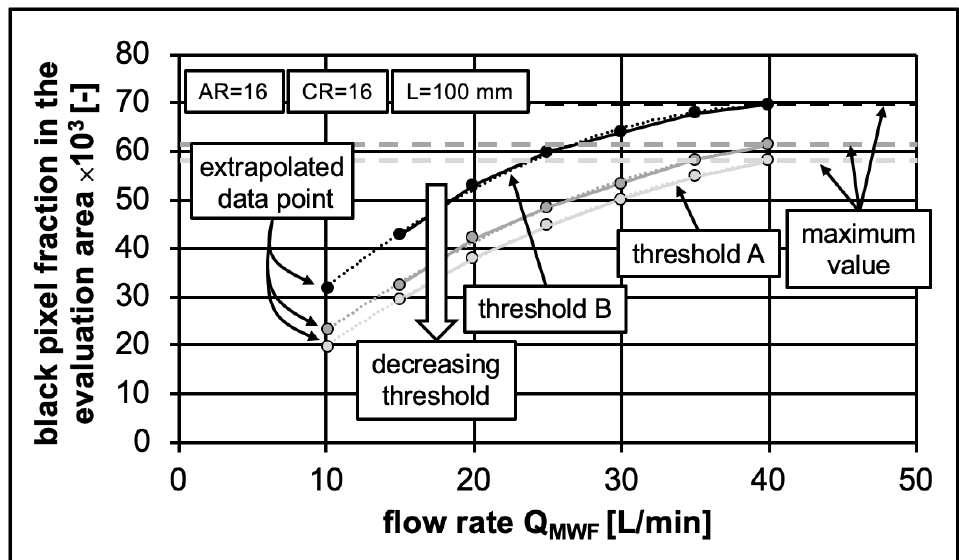
Figure 16. Black pixel fraction with different threshold values.